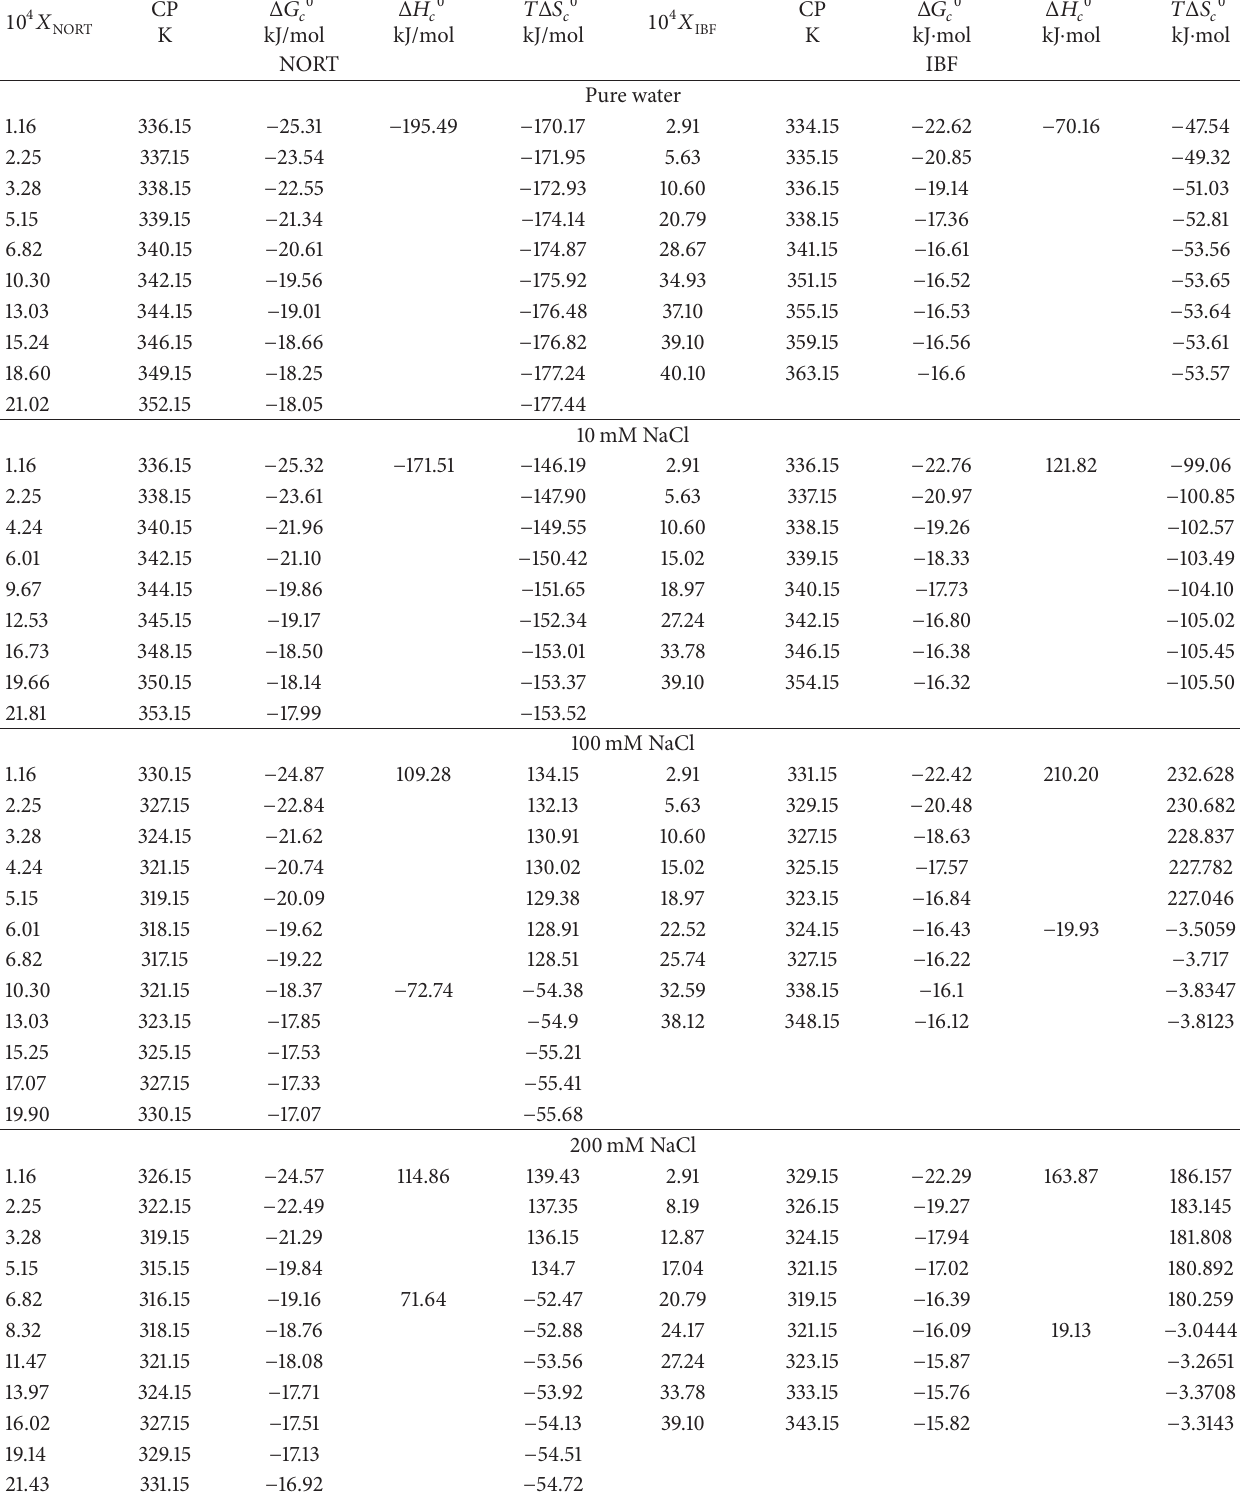
Table 2: Effect of drug on the cloud point (CP) and energetic parameters for clouding in 1.0 weight percent of hydroxypropylmethyl cellulose (HPMC) solutions in the presence of various salts. The uncertainties in the CP values lie within ± 0.1 degree. 10 4 𝑋